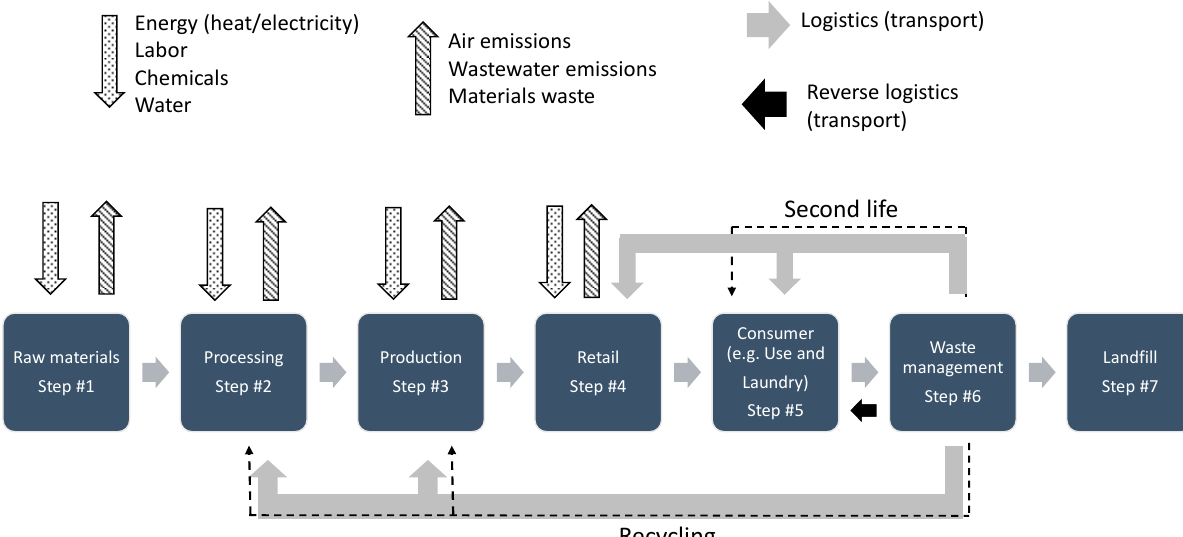
Figure 2. Supply chain of fashion products and life cycle steps. Logistics and reverse logistics create air emissions due to tire abrasion on roads or hydrocarbon fuel combustion in maritime, air, and road transportation.